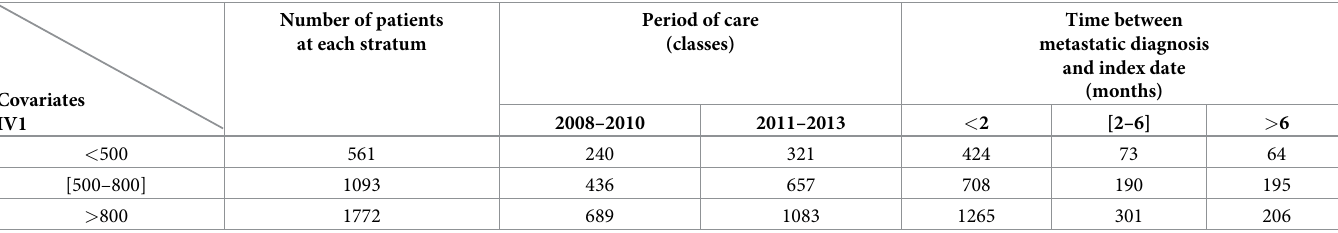
Number of patients at each stratum